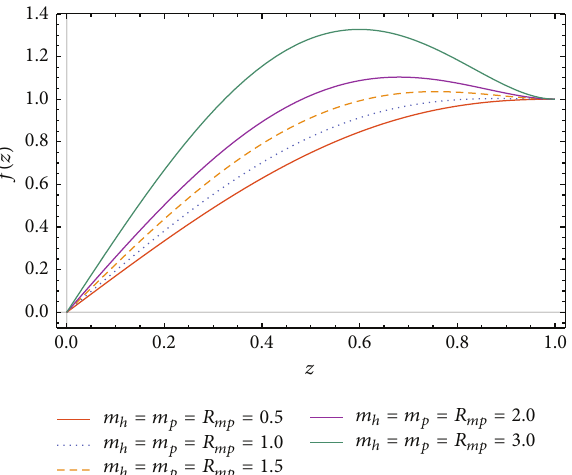
Figure6:Velocityprofilefordifferentvaluesof 𝑅 𝑚𝑝 with 𝑚 ℎ = 𝑚 𝑝 = 0.5 .